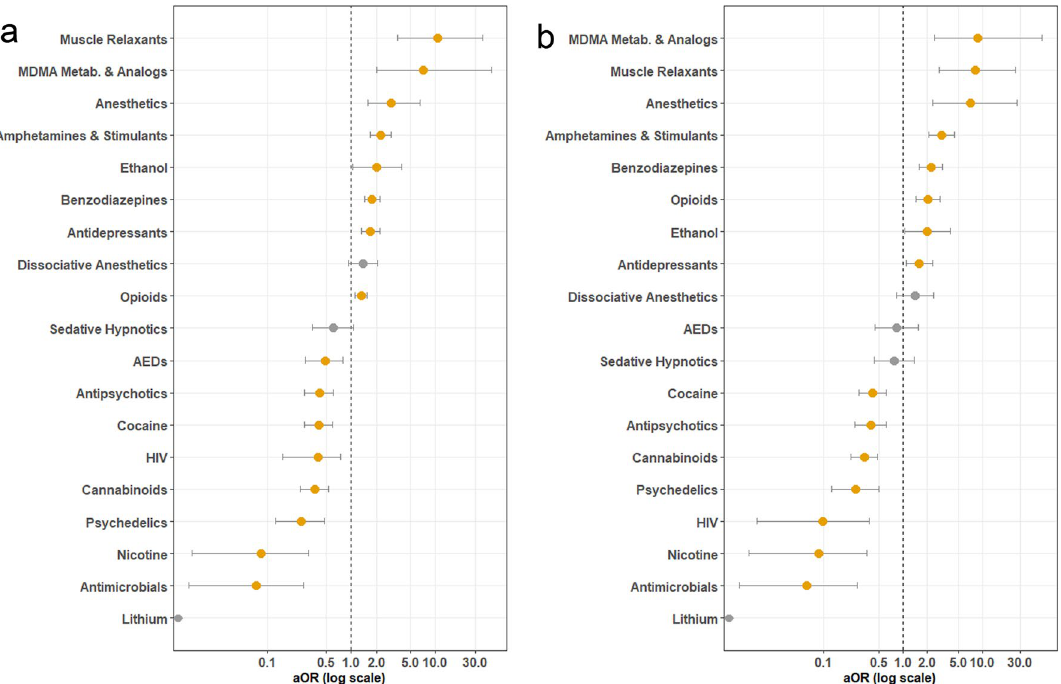
Figure 3. Multivariate analysis of concomitant drug use impact on odds of death in MDMA records. Multivariate adjusted odds ratios (aOR) for the reported risk of death shown for records with concomitant use of each drug class. X-axis presented here in log scale. Significant findings shown here in orange and non-significant findings are denoted in grey. 95% Confidence intervals shown as whiskers (note that the aOR for Lithium is incalculable due to no occurrences of death in the study). aORs greater than 1 indicate an increased reported risk of death. aORs less than 1 indicate a decreased reported risk of death. ( a ) The number of concomitant drugs in each class as a predictor of death. Note that only drug classes that were selected by stepwise regression are shown here. ( b ) Each drug class as a binary predictor of death. Note that only drug classes that were selected previously for panel ( a ) are shown here in panel ( b